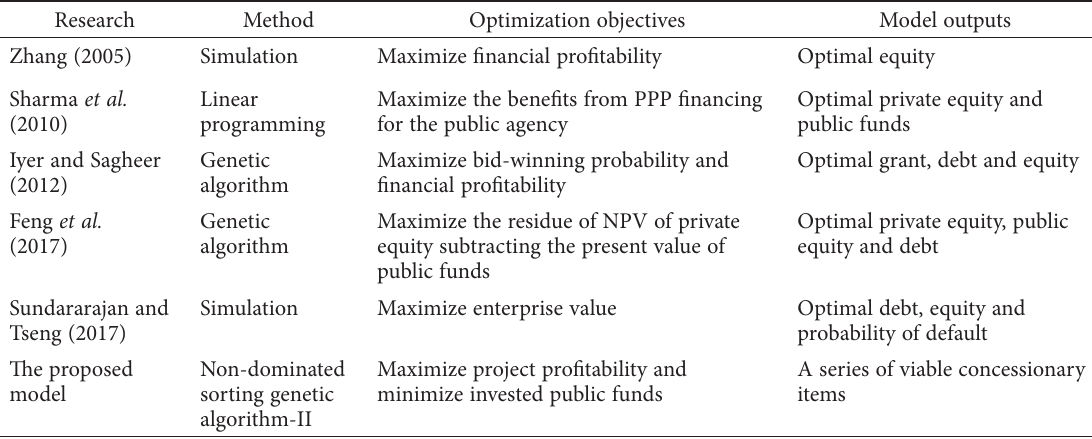
Table 8. Comparison of model results with previous